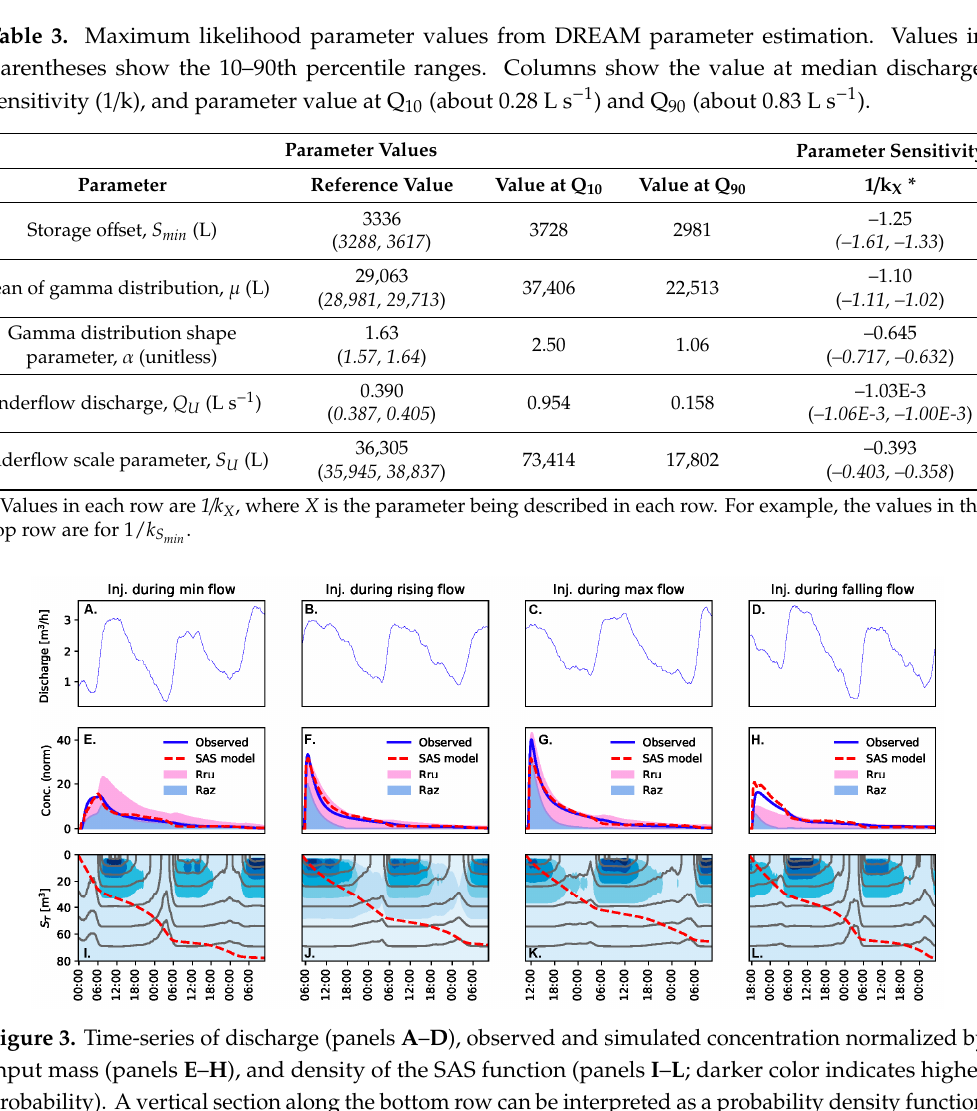
Table 3. Maximum likelihood parameter values from DREAM parameter estimation. Values in parentheses show the 10–90th percentile ranges. Columns show the value at median discharge,